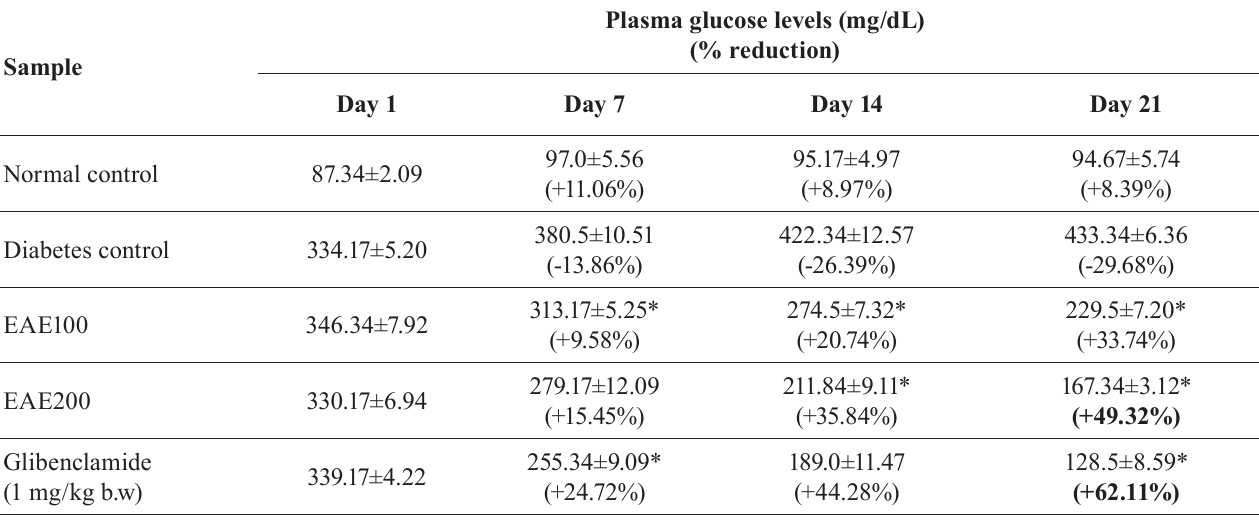
TABLE II – Blood glucose levels of STZ-induced diabetic rats administered with EAE observed within 21 days of treatment